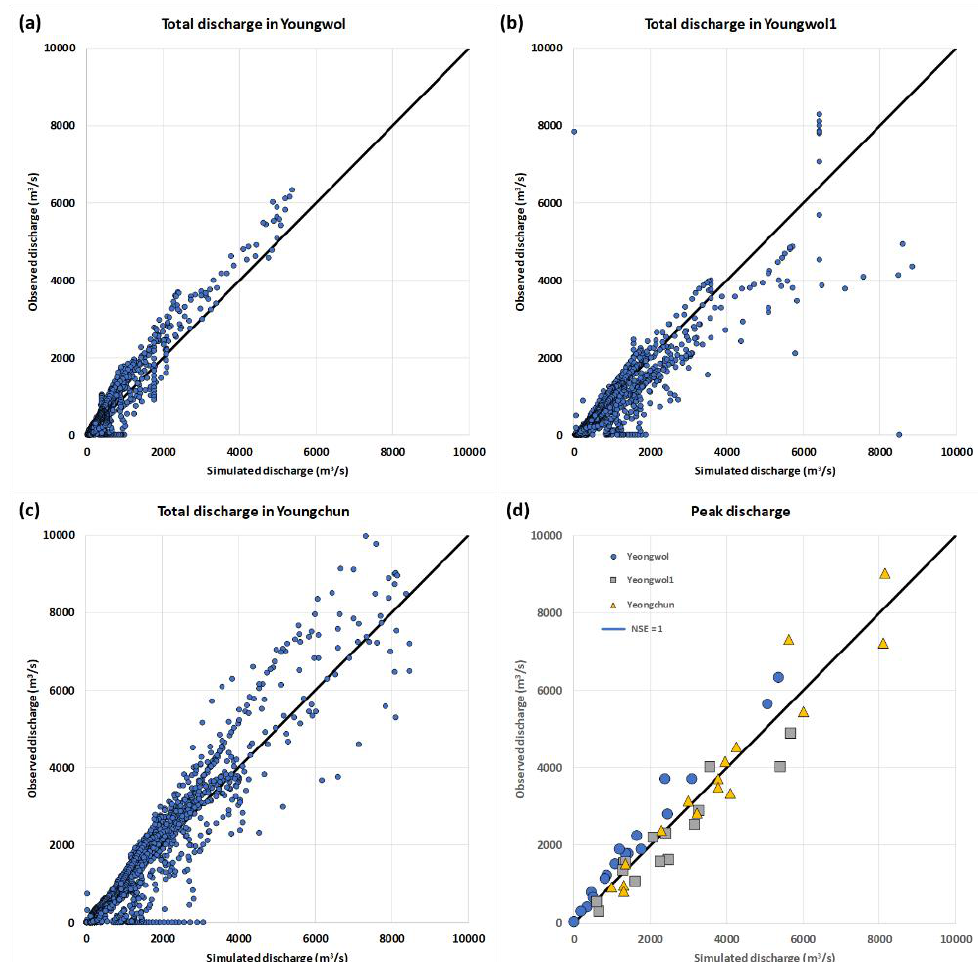
Figure 6. Comparison between observed and simulated peak streamflow values at propagated points. ( a – c ) all discharge comparisons at YW, YW1, and YC, ( d ) peak discharge comparisons.